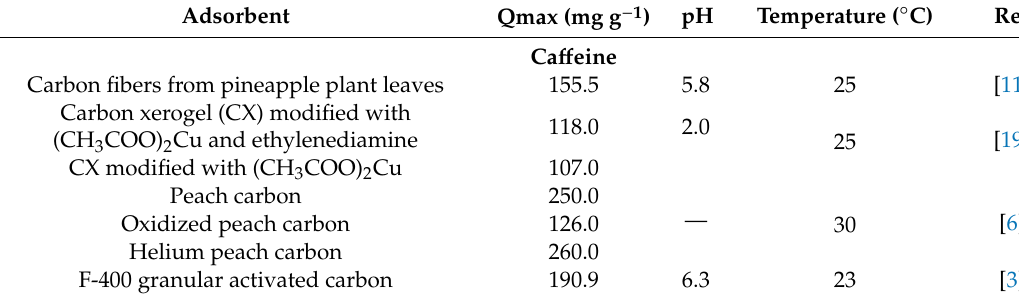
Table 4. Comparison of the adsorption capacity of ca ff eine and diclofenac considering the Qmax parameter of the Langmuir model with other